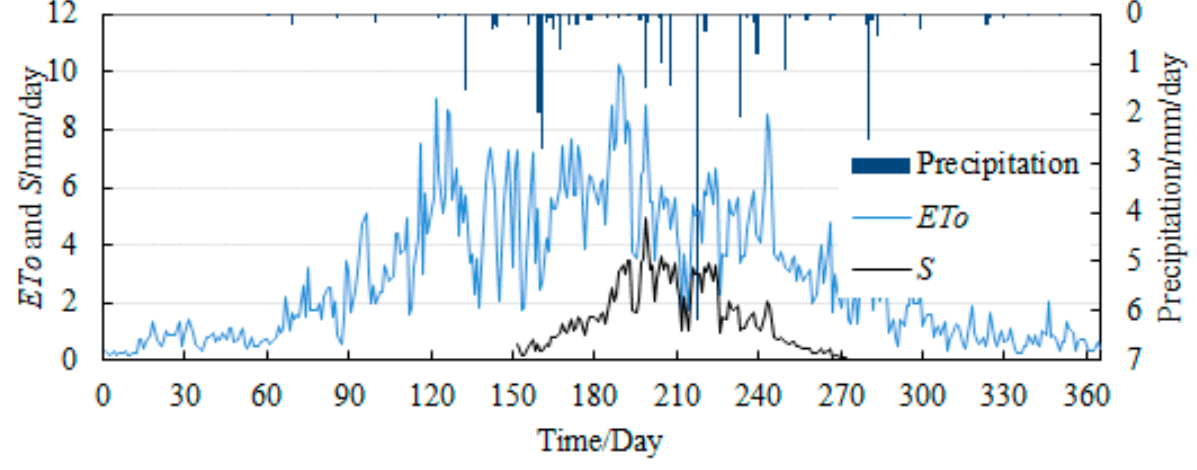
Figure 5. Rainfall, ETo and S calculation of Tongliao station.